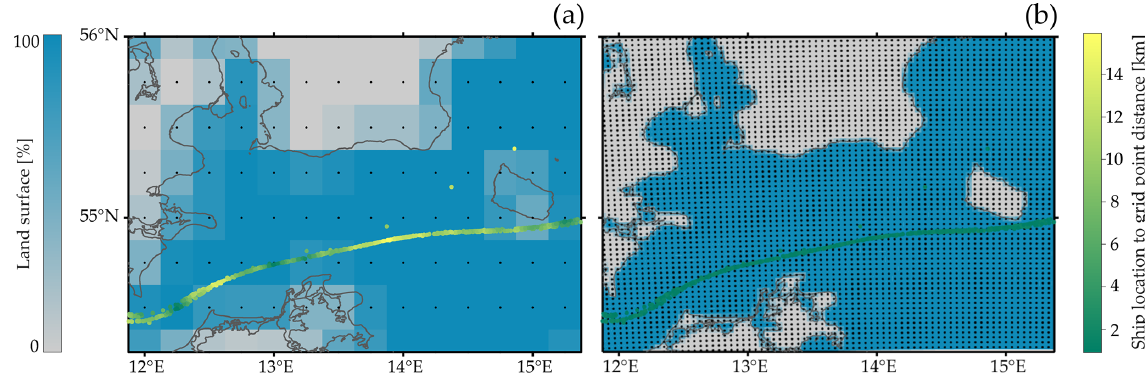
Figure 3. Land–sea mask for ERA5 (a) and NEWA (b) grids. For each grid point (black dots), the ratio between land and water in the corresponding grid box is shown. Hourly ship positions are included in a green to yellow color scale, indicating the distance between each hourly vessel position and the nearest grid point.